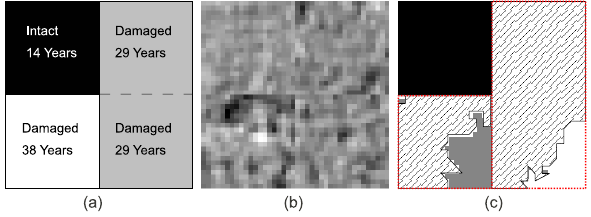
Figure 2: (a) Actual regions, (b) Blue band test frame, (c) Seg- mented regions using ( h s , h r ) = (5 , 10) , maximal overlaps per region are hatched. Segmentation performance